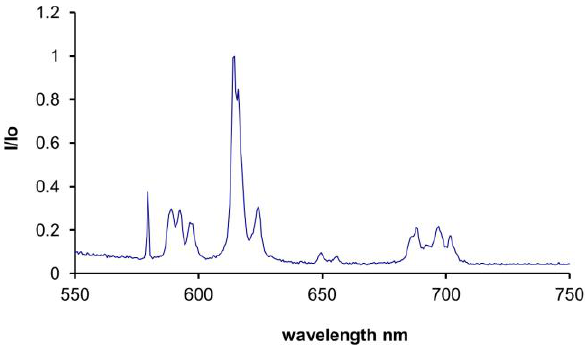
Figure 8. Emission spectrum for EuL14 in H2O λ ex = 265